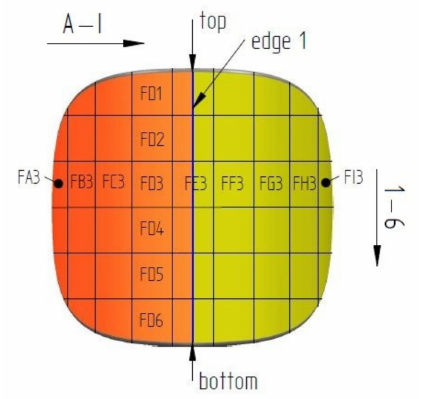
Figure 6. Front surface with the way of notification of designated